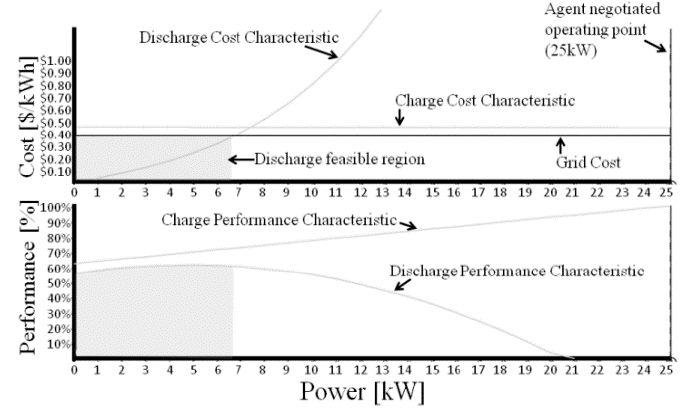
Figure 16. The post-disturbance cost and performance characteristics for the storage producer and consumer agents. The solid vertical line represents the actual battery dispatch.